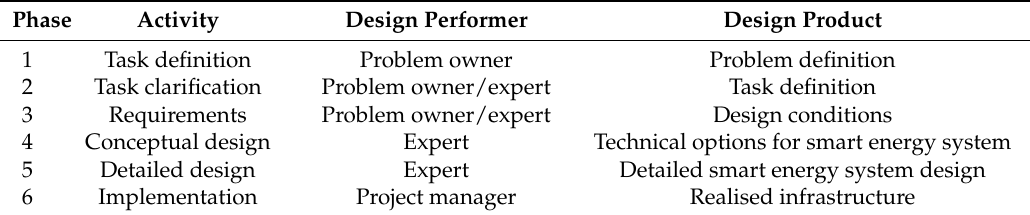
Table 1. Design activities, performers, and products.